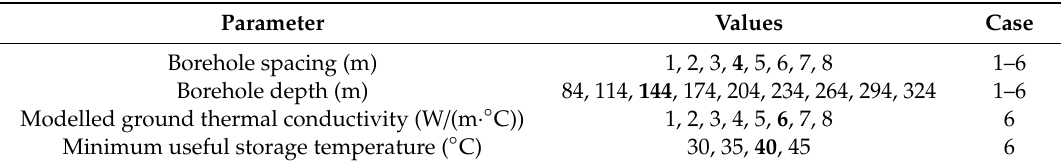
Table 2. Parameters and parameter ranges considered in the sensitivity analysis of the borehole thermal energy storage (BTES) performance. Bold print denotes actual design and geological values for the BTES at Xylem,